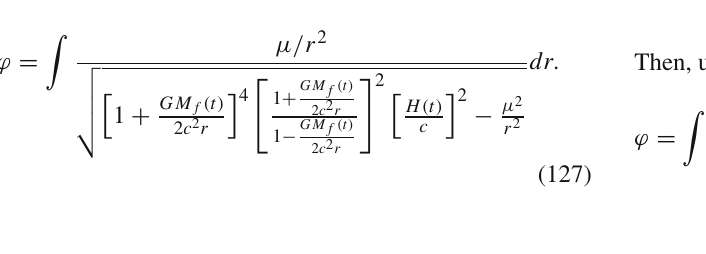
Fig. 2 In a non-static case, both r e and Δϕ change over time, unlike the corresponding Einstein’s values remaning always unchanged in a central field (from a source with a constant